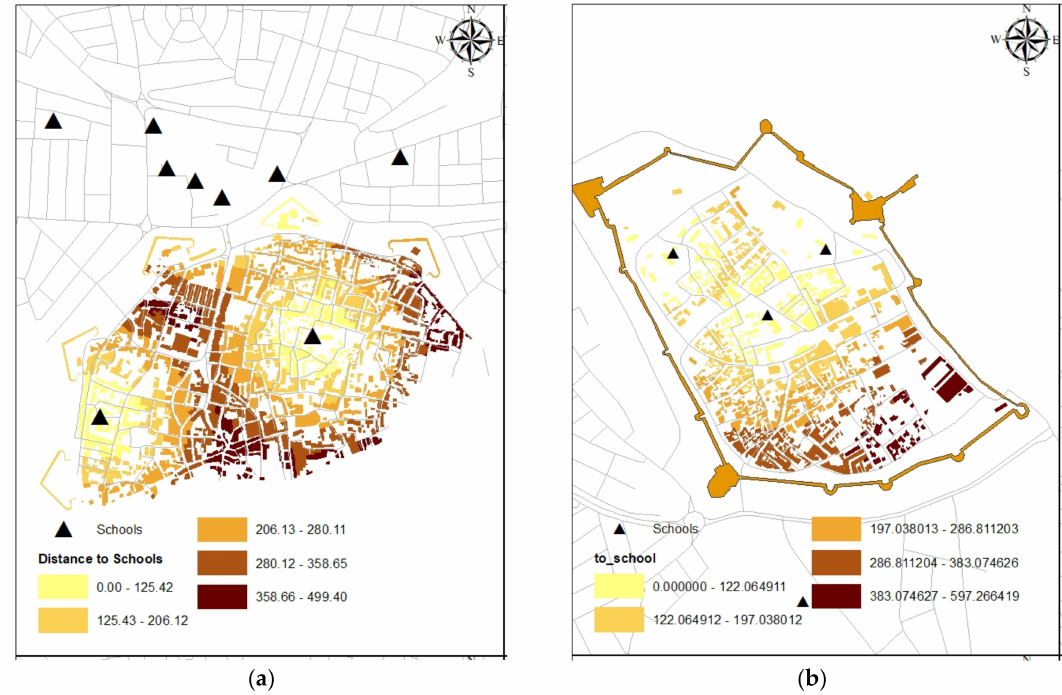
Figure 5. Accessibility to Schools in Nicosia ( a ) and Famagusta ( b ) Walled Cities. Proximity to basic services, distance to shopping areas, and distance to school (T1): Accessi- bility to basic services is one of the essential dimensions of sustainable urban